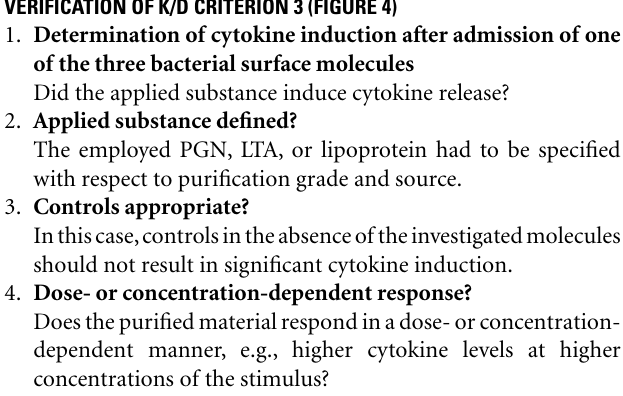
VERIFICATION OF K/D CRITERION 3 (FIGURE